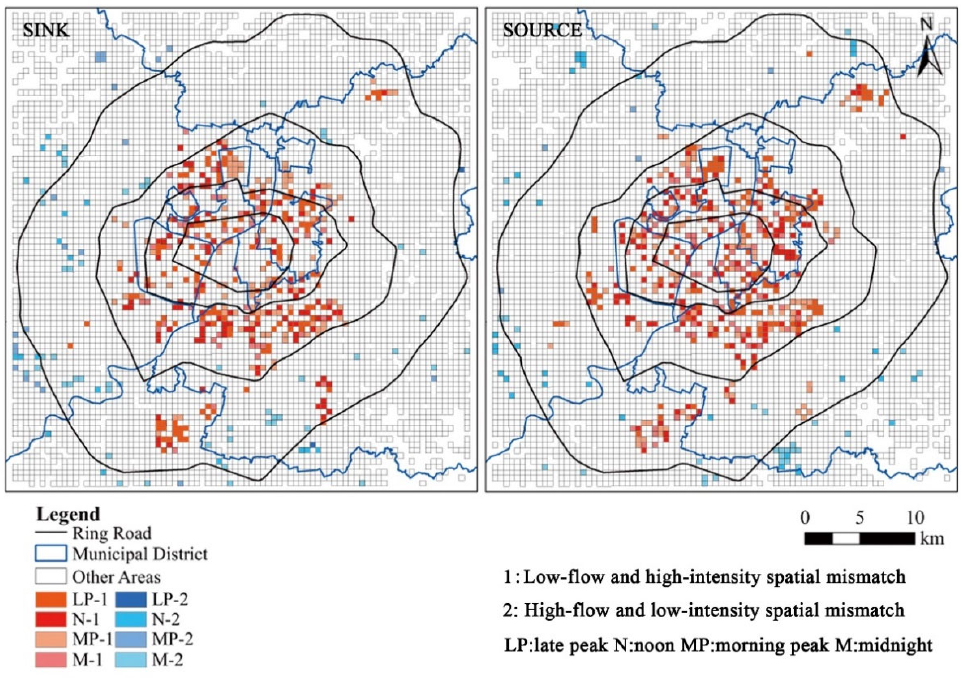
Figure 8. 20180515 Spatial mismatch area between population source ‐ sink and FAR.